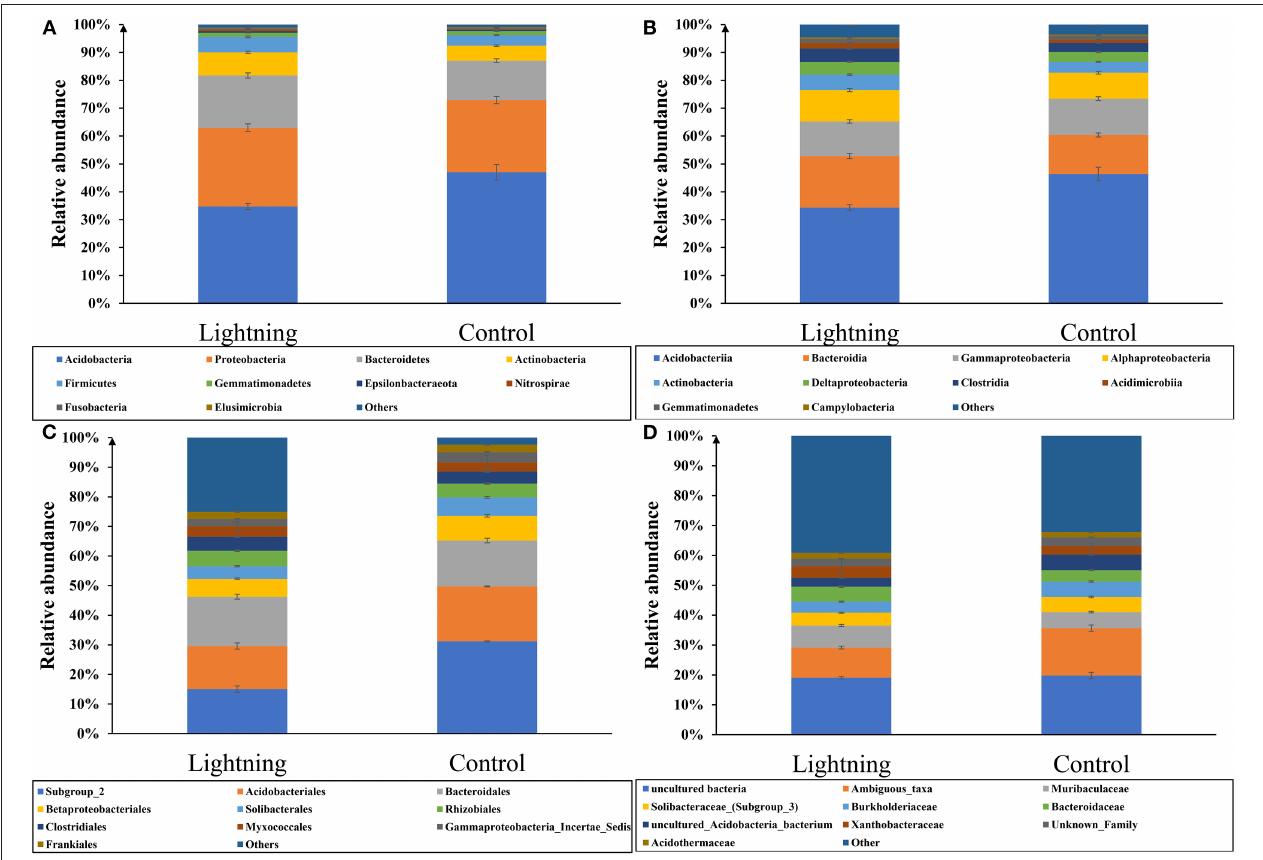
FIGURE 3 | Relative abundance of taxa (top 10) at the phylum (A) , class (B) , order (C) , and family (D) level. Lighting represents a sample 10m from the lightning rod; Control indicates that the distance between the sample and the lightning rod is > 1,500m.